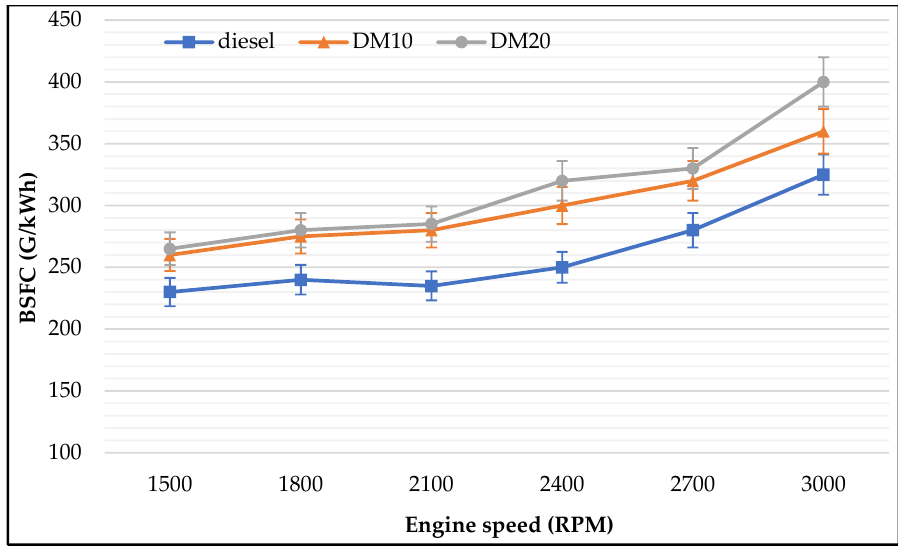
Figure 9. Brake Specific fuel consumption (BSFC) at different engine speeds. Energies 2022 , 15 , x FOR PEER REVIEW